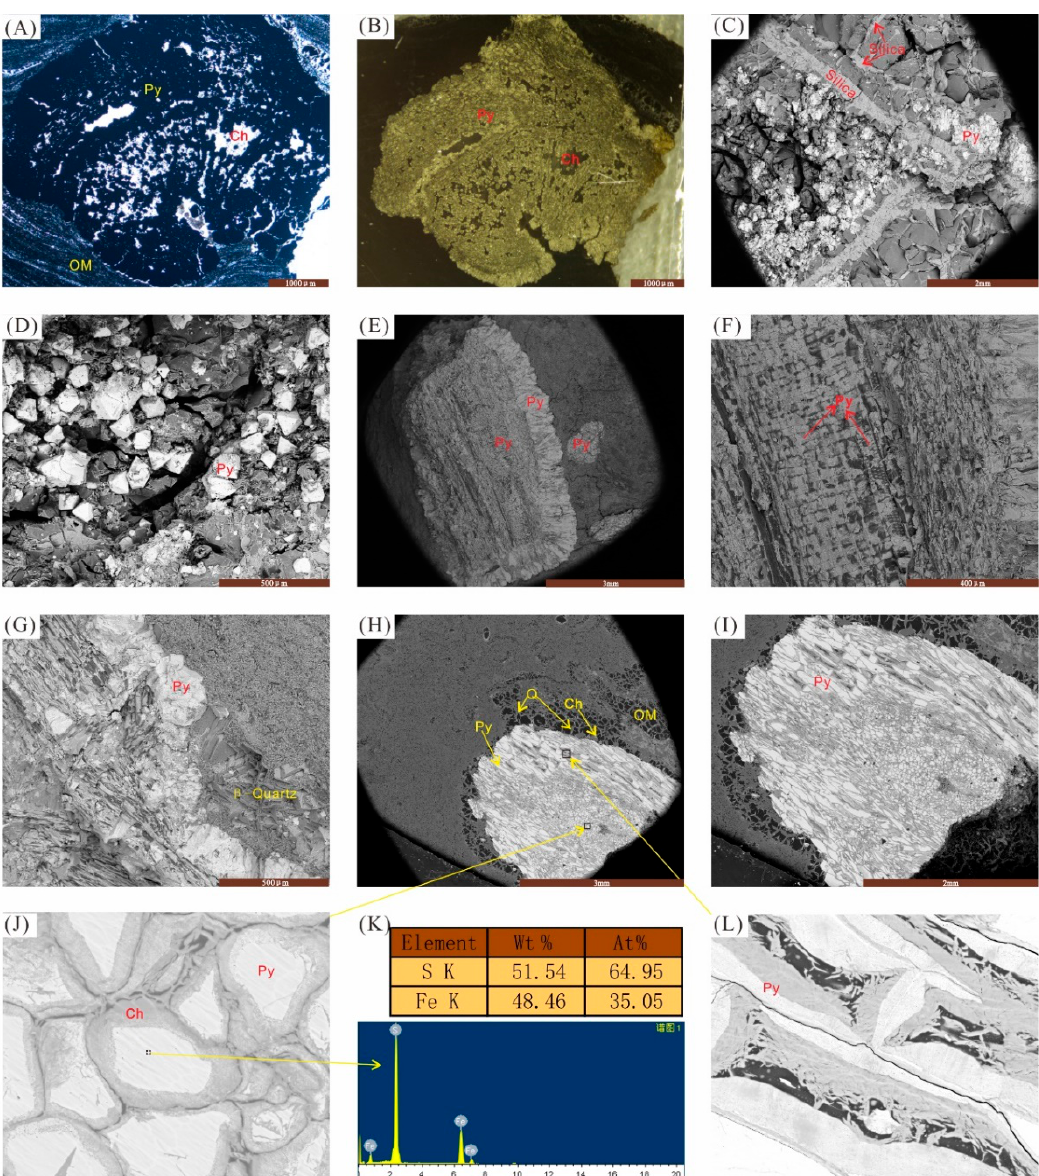
Figure 6. Pyrite occurrence modes in coal. ( A ) Pyrite occurring as isolated euhedral particles in plane-polarized light (PPL); ( B ) Photomicrographs of ( A ), reflected light in air; ( C , D ) Pyrite on the surface of Lepidodendron . SEM back-scattering images (BSED); ( E ) Pyritic coal balls SEM BSED; ( F ) Magnification of ( E ), vegetative organs and reproductive organs with well-preserved plant cell tissue SEM BSED; ( G ) Pyrite aggregates in bands that are parallel to the stratification direction SEM BSED; ( H ) Pyritic coal balls as isolated anhedral bodies in collodetrinite SEM BSED; ( I ) Magnification of ( H ), pyritized tissues with different form SEM BSED; ( J ) Magnification of ( H ), pyrite enclosed by the Fe-Mg-rich siliceous material SEM BSED; ( K ) EDS data for pyrite; ( L ) Magnification of ( H ), the remnants of organic matter SEM BSED. Py, pyrite; Q, quartz; Ch, chamosite; OM, organic matter. ( C – G ) naturally exposed surface; ( H – J , L ) ion-polished surface. The SEM images show that vegetative organs and reproductive organs of plant cell tissues are well preserved inside the pyritic coal balls (Figure 6E,F), indicating that pyritic coal balls originated late in the peat stage, but before the peat was strongly compacted